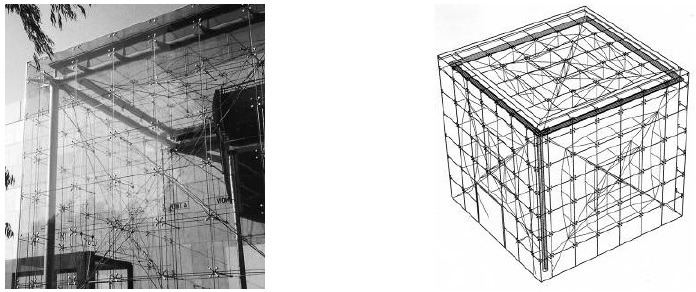
Figure 13 and 14: Entrance cube of the Museum of Modern Art of Tel Aviv